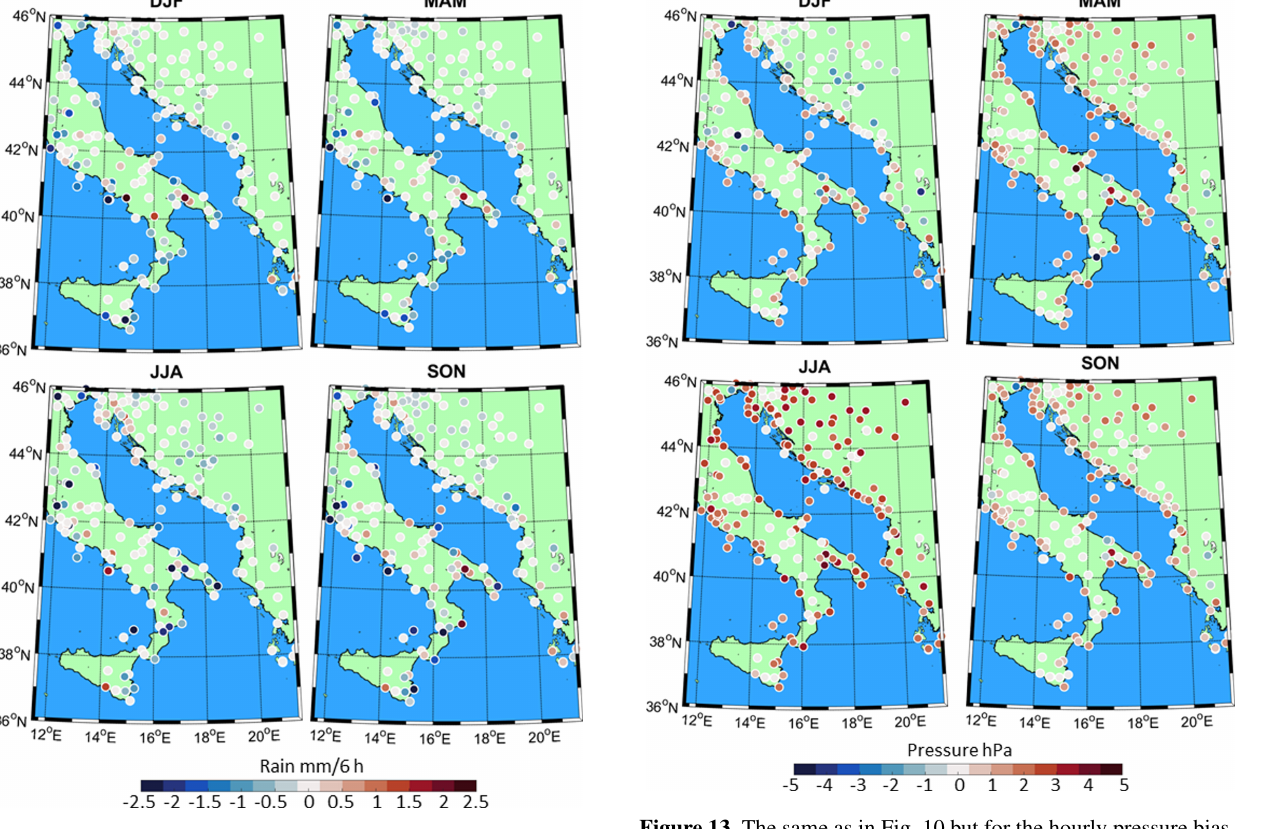
Figure 12. The same as in Fig. 10 but for the mean 6-hourly rain bias.